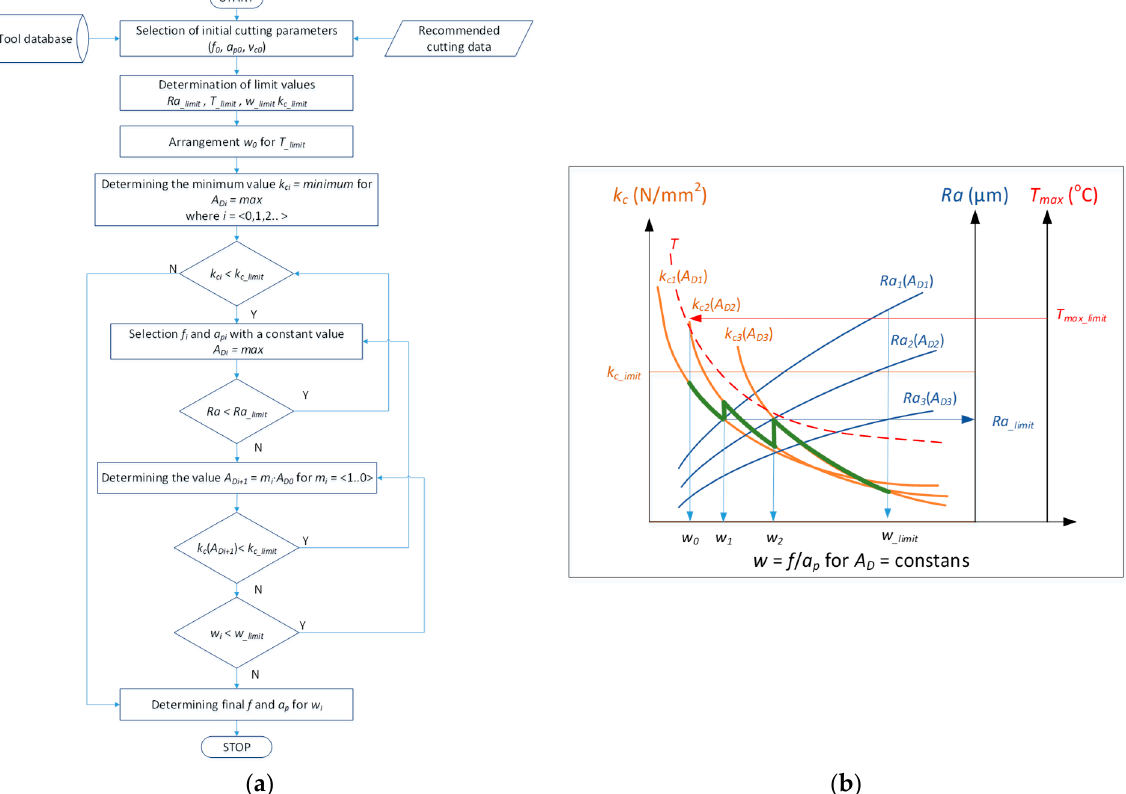
Figure 9. Simplified algorithm of procedure ( a ) for minimizing the value of the actual cutting resistance and the schematic diagram of the method ( b ).